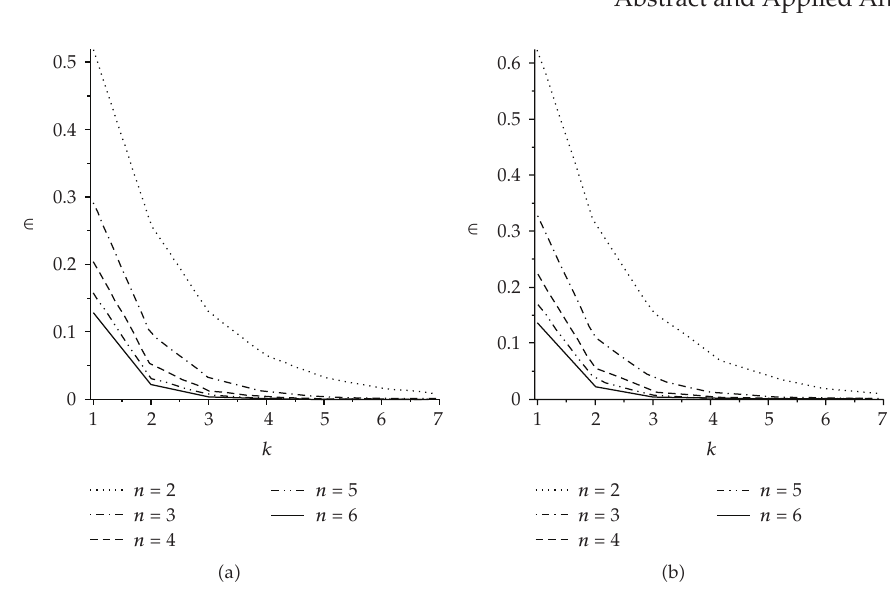
Figure 4: (cid:3) a (cid:4) Presents comparison among the error bounds of di ff erent arity subdivision volumetric models (cid:3) 4.1 (cid:4) , that is, for n (cid:9) 2 , 3 , 4 , 5 , 6; (cid:3) b (cid:4) presents comparison among the error bounds of di ff erent arity subdivision volumetric models (cid:3) 4.3 (cid:4) , that is, for n (cid:9) 2 , 3 , 4 , 5 , 6. Here k presents subdivision level, n presents the arity and (cid:5) presents the user-specified error